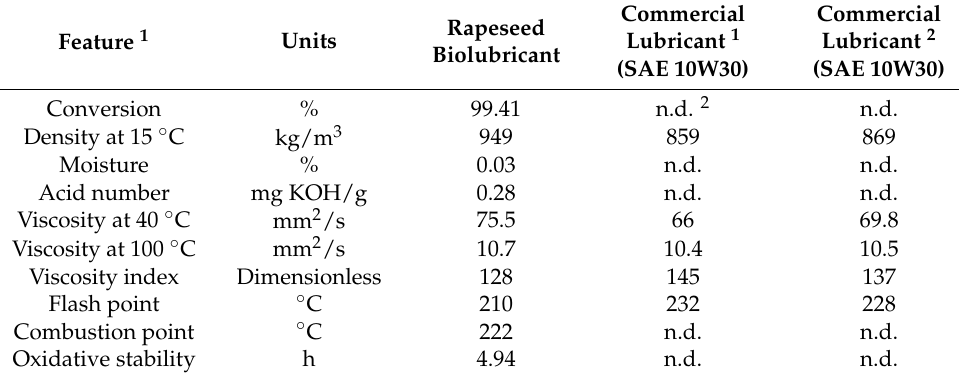
Table 3. Main features of rapeseed biolubricant.